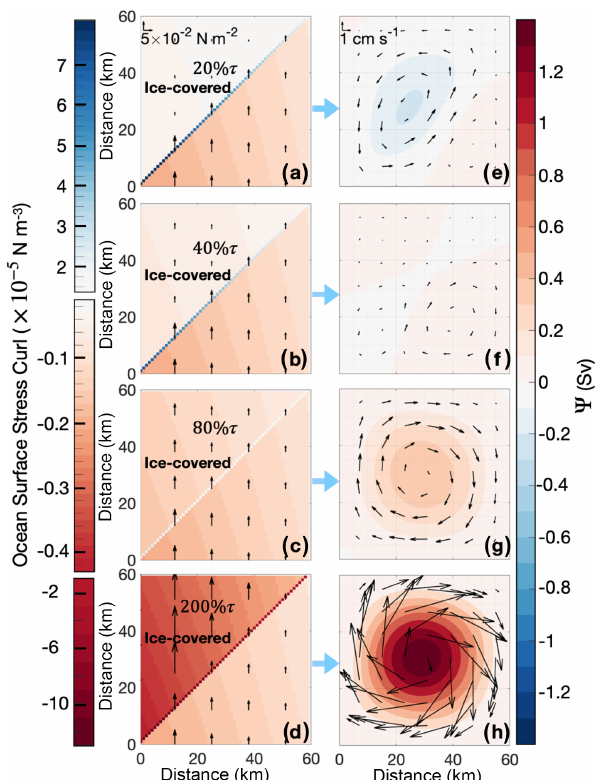
Figure 12. (a–d) Ocean surface stress (arrows; only every 13th ar- row is plotted for clarity) and ocean surface stress curl (shading) for (a) 20% ,τ (b) 40% ,τ (c) 80% τ and (d) 200% τ transferred to the ocean. Sea ice covers the northwestern half of the gyre domain (i.e. SeaIce π ) and the StrongCyclonic wind field is applied. (e–h) Sim- 4 ulated streamfunction ( (cid:57), shading) and ocean current velocity (ar- rows; only every eighth arrow is plotted for clarity) resulting from the forcing in panels (a–d) respectively.